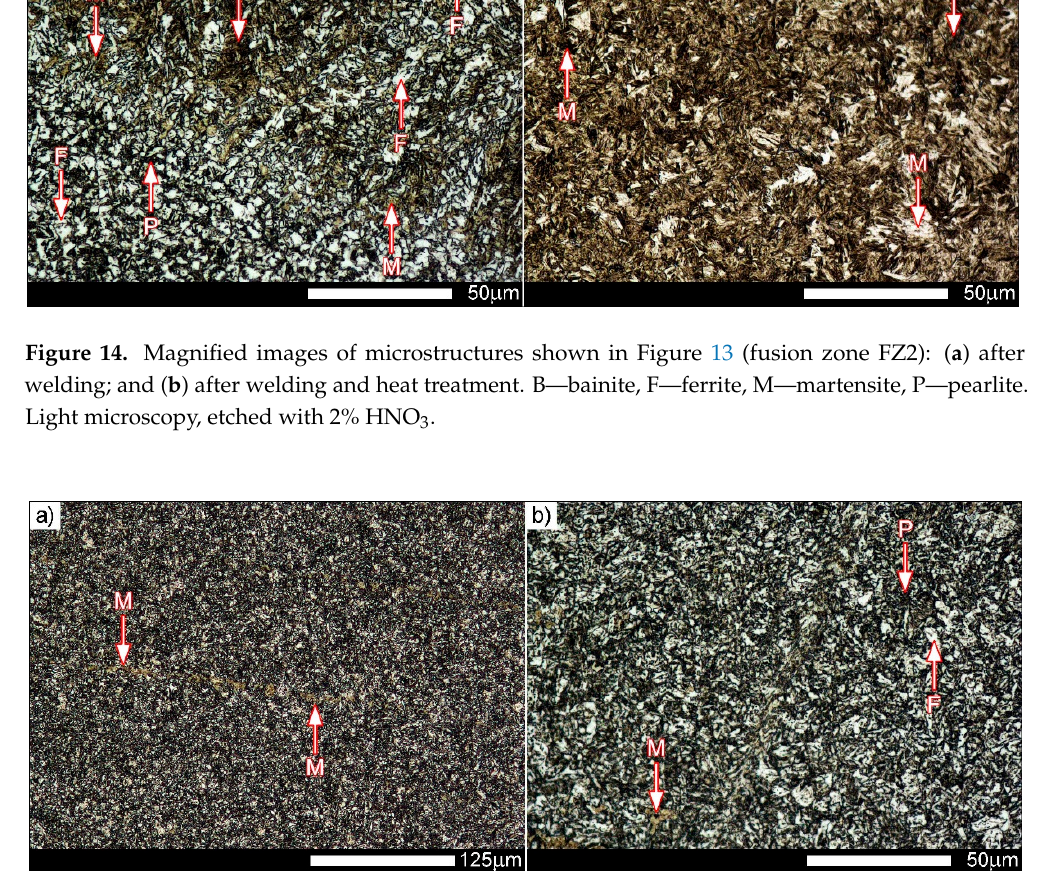
Figure 16. Macroscopic images of fracture surfaces of selected Hardox 600 joints listed in Table 5: ( a ) AW-UTS-3; ( b ) HT-UTS-1; ( c ) AW-KCV-3; and ( d ) HT-KCV-1; C1/D1: zone below the notch; C2/D2: central zone of the fracture; C3/D3: final fracture zone; C4/D4: side zone of the fracture. Light microscopy, unetched.